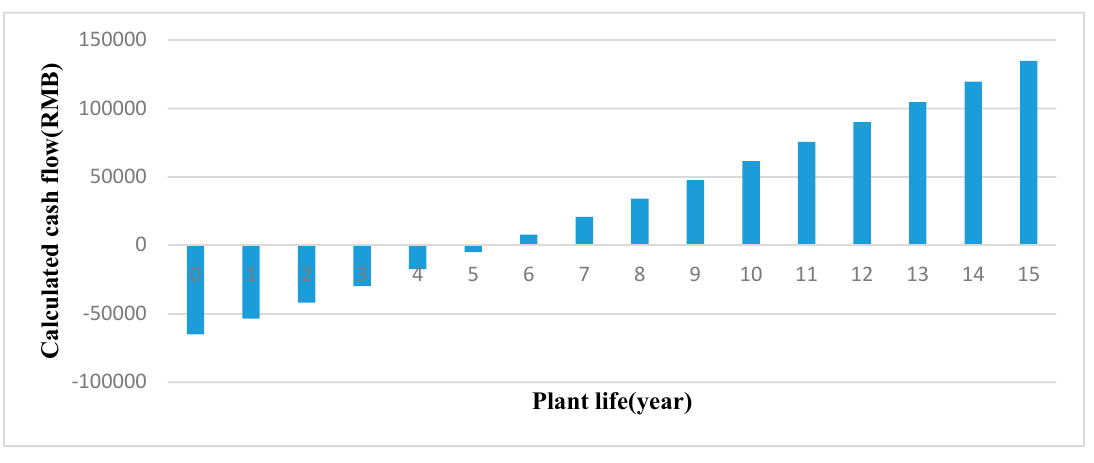
Figure 4. Cumulative cash flow chart.